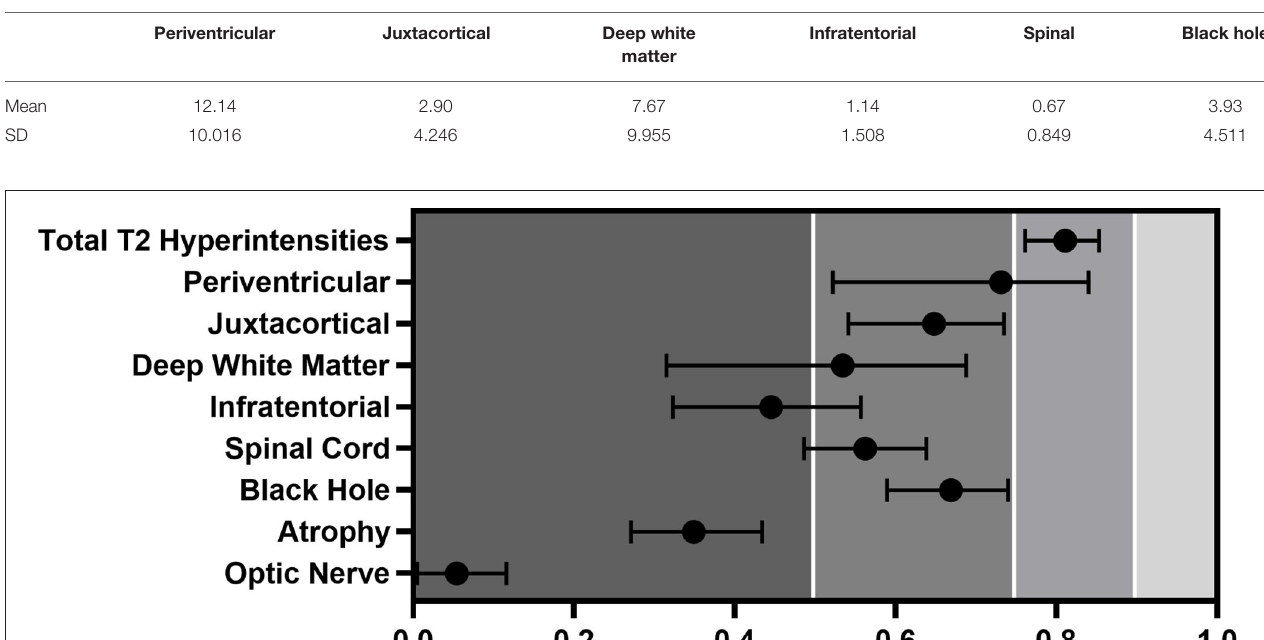
TABLE 3 | Average lesion count per region.